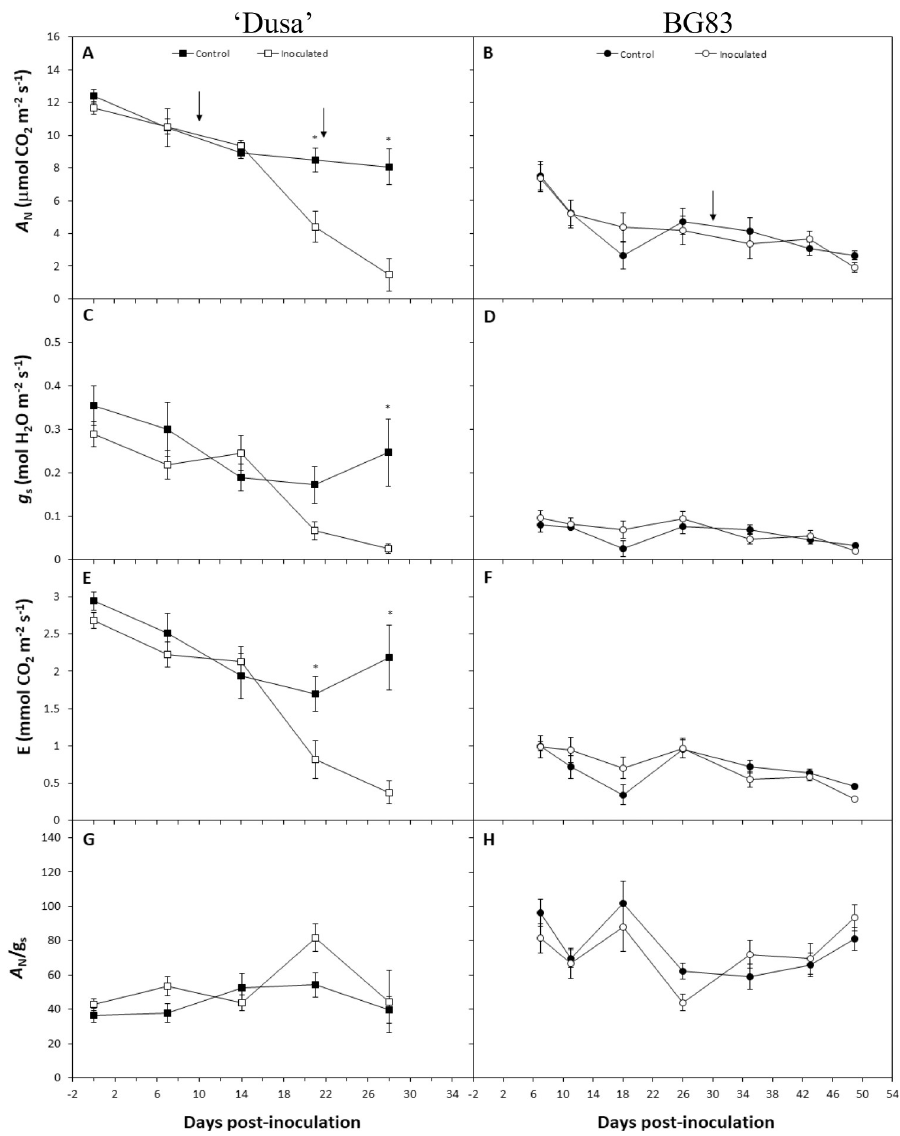
G and H) in ‘Dusa’ and BG83 avocado plants at stage 1 (no aerial symptoms) after inoculation with R . necatrix . The asterisks indicate significant differences between inoculated and control treatments ( P < 0.05). Each data point represents the mean ( ± SE; n = 8 to 18). The arrows indicate root sampling for RNA